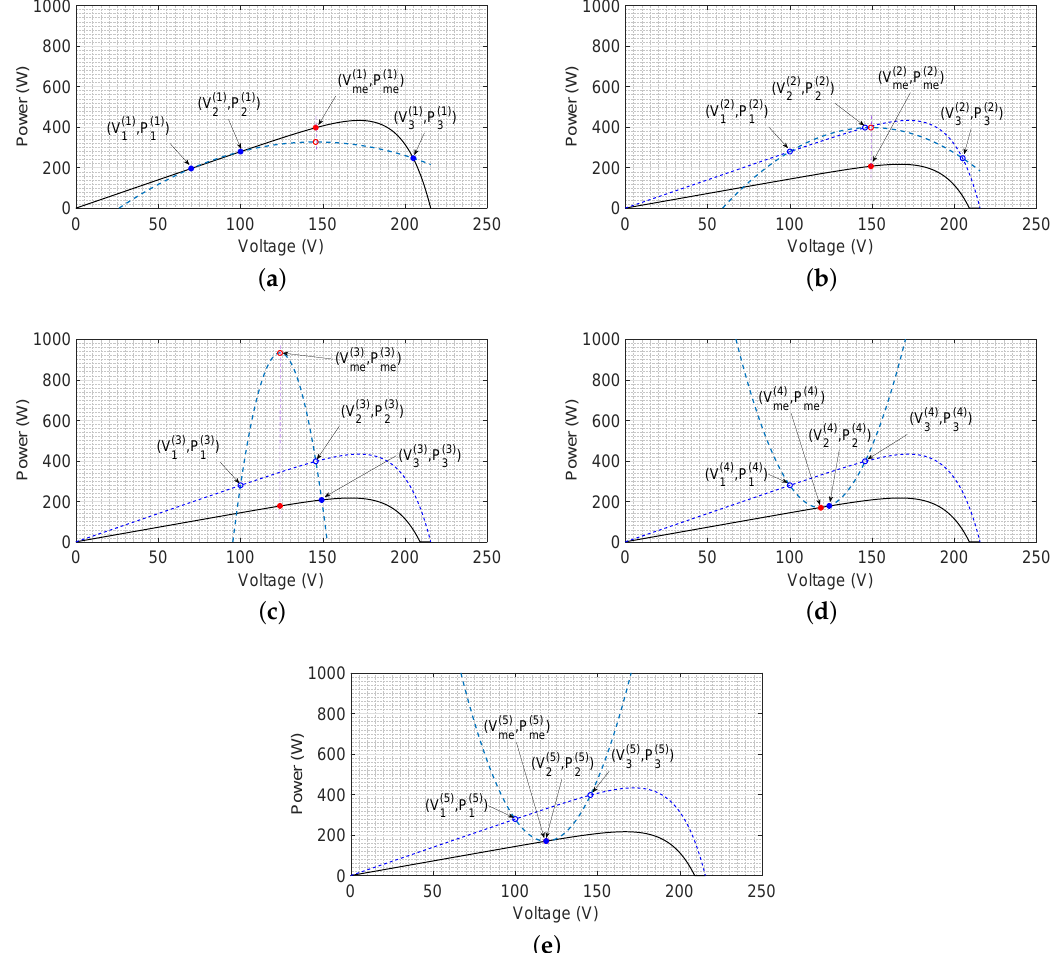
Figure 23. NQI under sudden irradiance changes. ( a ) 1st; ( b ) 2nd; ( c ) 3rd; ( d ) 4th; and ( e ) 5th iteration.